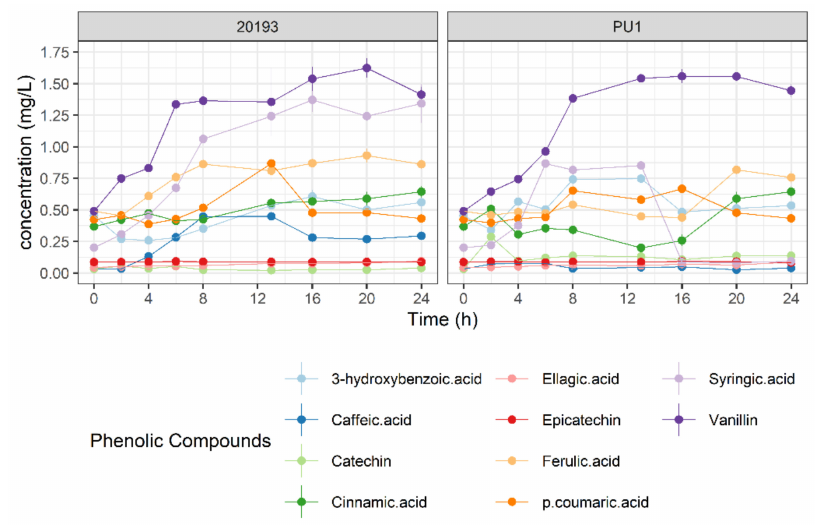
Figure 4. Profile evolution of phenolic compounds of Finnish brewers’ spent grain (FL-BSG) fer- mented with Lactiplantibacillus plantarum PU1 and Leuconostoc pseudomesenteroides DSM 20193 for 24 h at 30 ◦